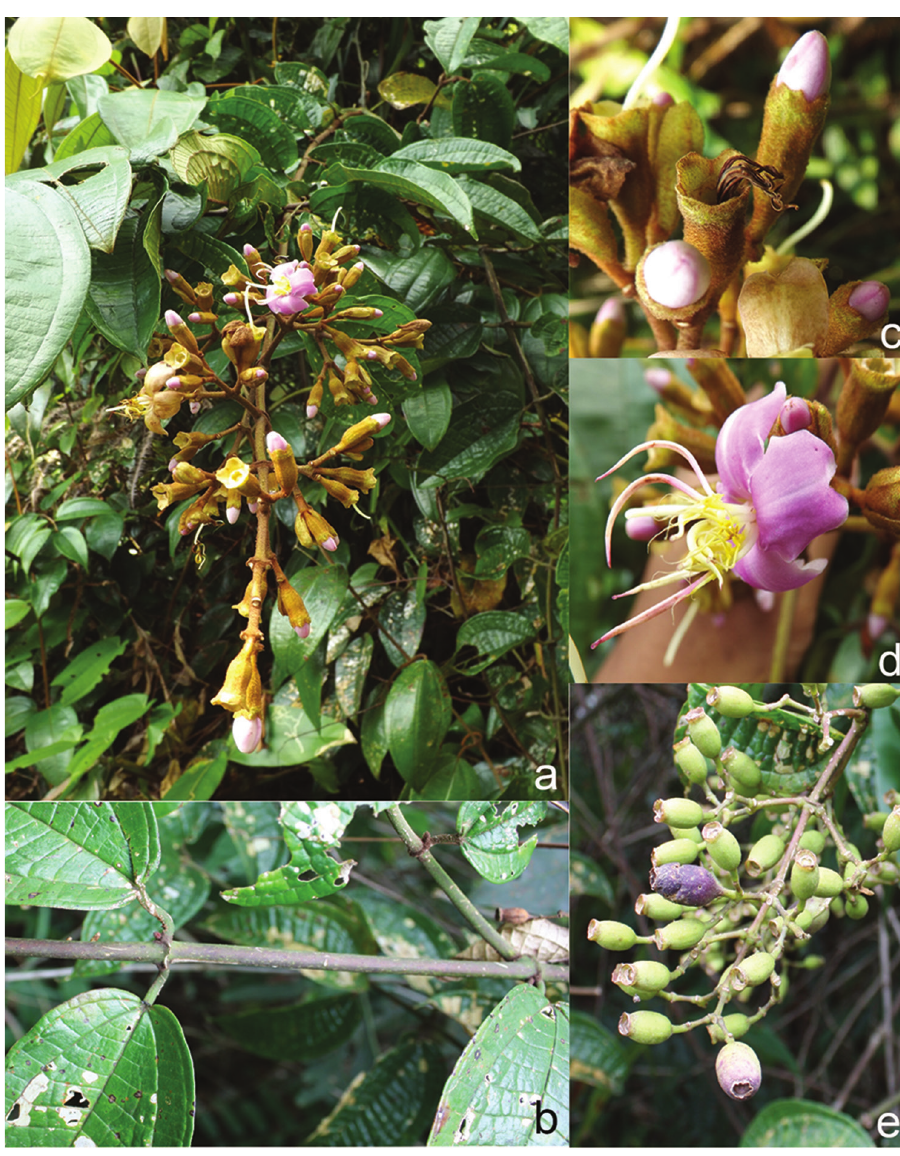
Figure 8. Dissochaeta bracteata a habit b branchlet c hypanthium d flower e fruits. Photographs by A. Kartonegoro; vouchers Kartonegoro 1074 (BO,